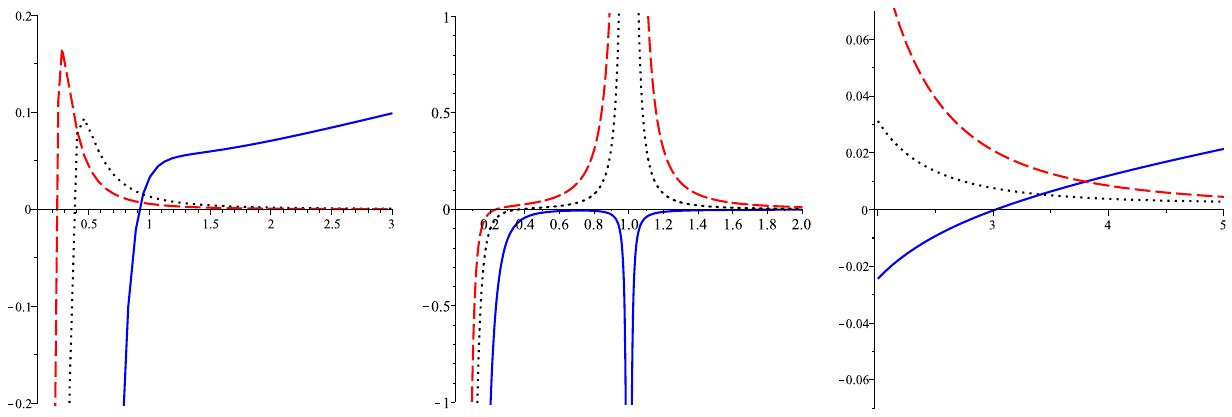
Fig. 7 T versus r + for q = 1, P = 1 / 8 π , m = 0 . 1, α = 1, c 1 = c 2 = c 3 = c 4 = 1, c 0 = 1 (solid lines), c 0 = 5 (dotted lines) and c 0 = 10 (dashed lines). Left panel for k = 0. Middle panel (0 < r + < 2) and right panel (2 < r + < 5) for k = − 1 with different scales